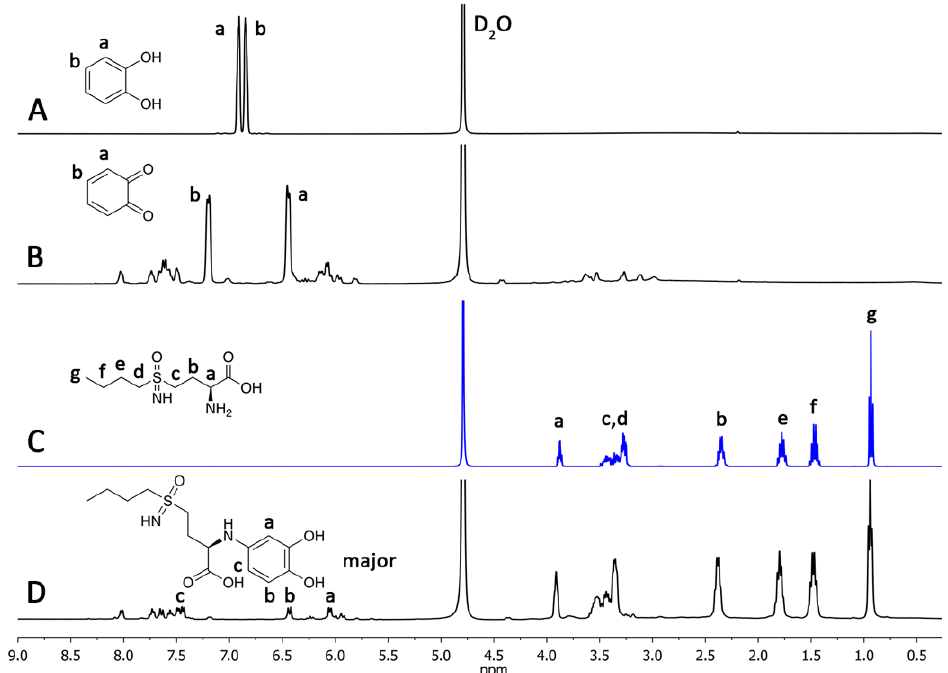
Figure 4. 1 H NMR spectra of the L -BSO derivatization reaction followed by NMR. Comparative